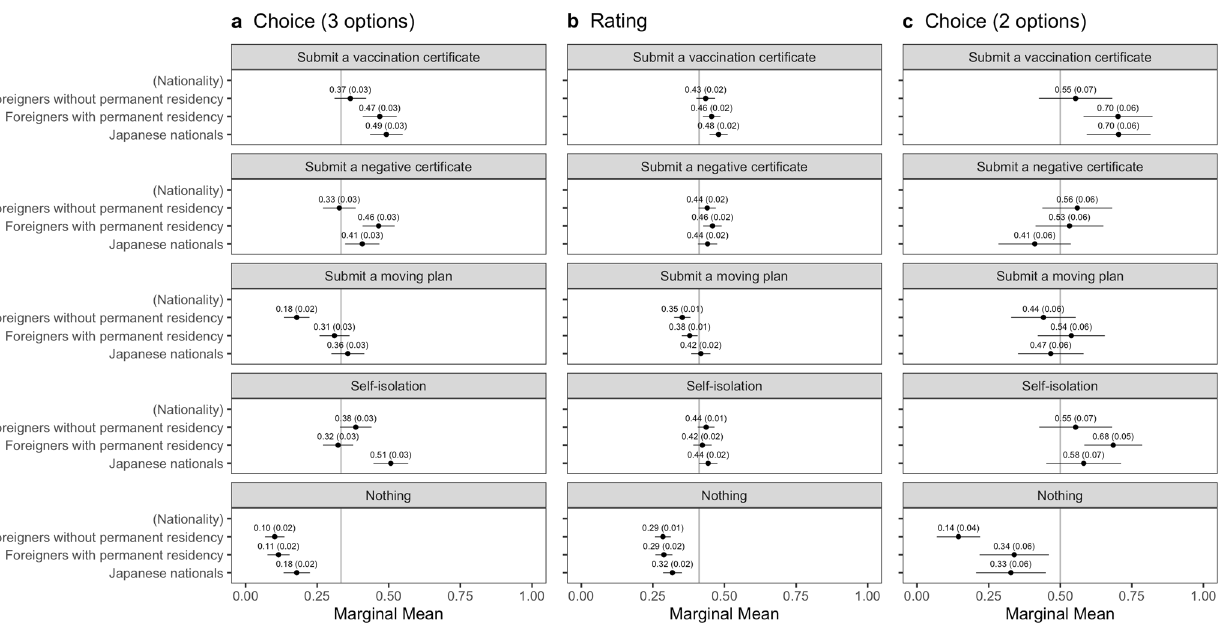
Fig. 3 The interaction effects of Quarantine_Certi fi cate with Nationality on the marginal means of the probability or rating for travelers ’ entry with error bars of 95% con fi dence intervals. The vertical lines show the random probability (0.33) for Panel a using the choice-based question (three options including “ Neither should be admitted ” ), the mean (0.41) for Panel b using the rating-based question, and the random probability (0.5) for Panel c using the choice-based question (two options).